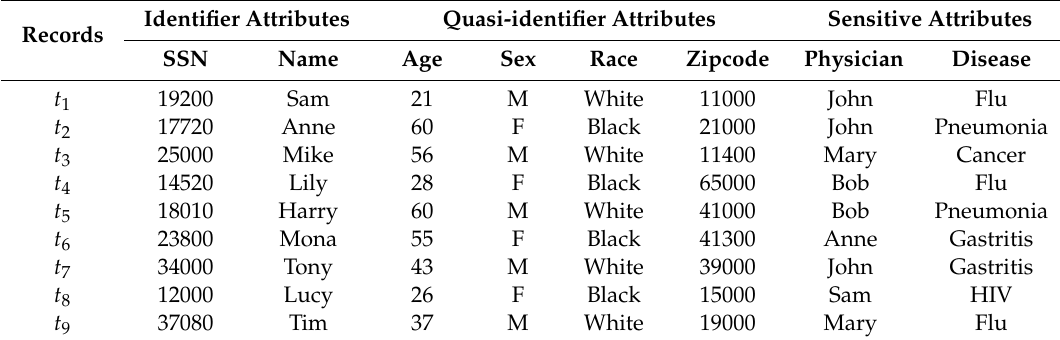
Table 1. An example of the